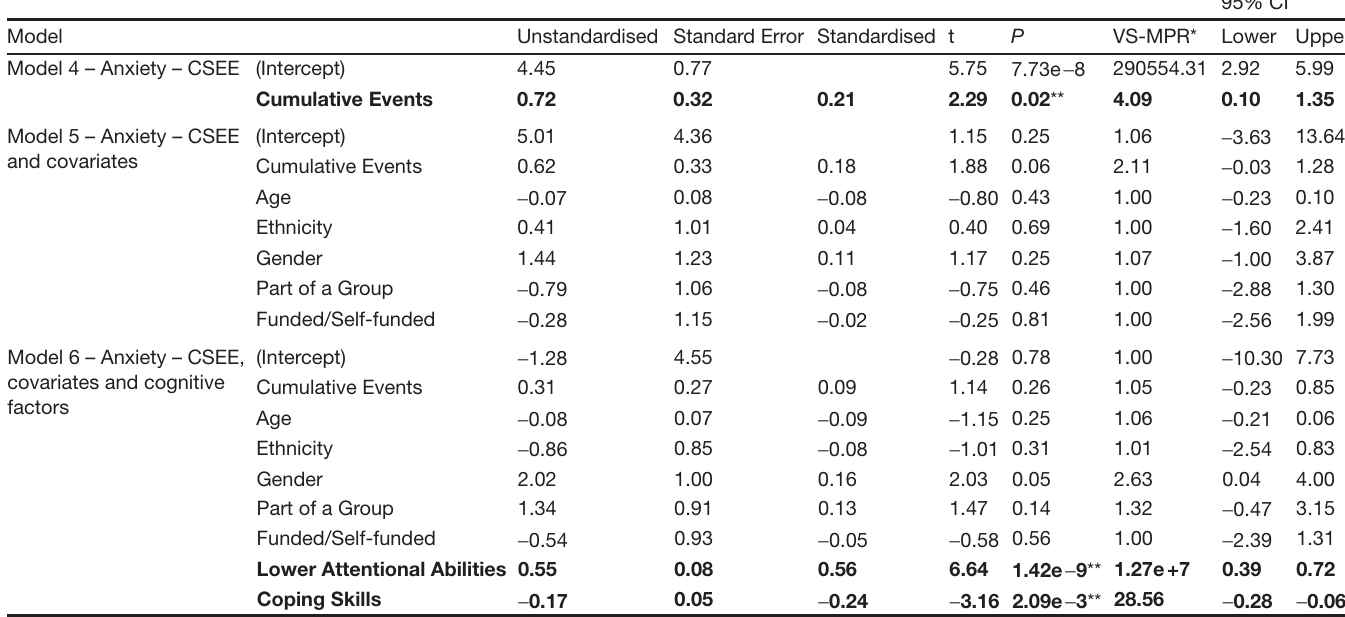
Table 6. Coefficients for anxiety models